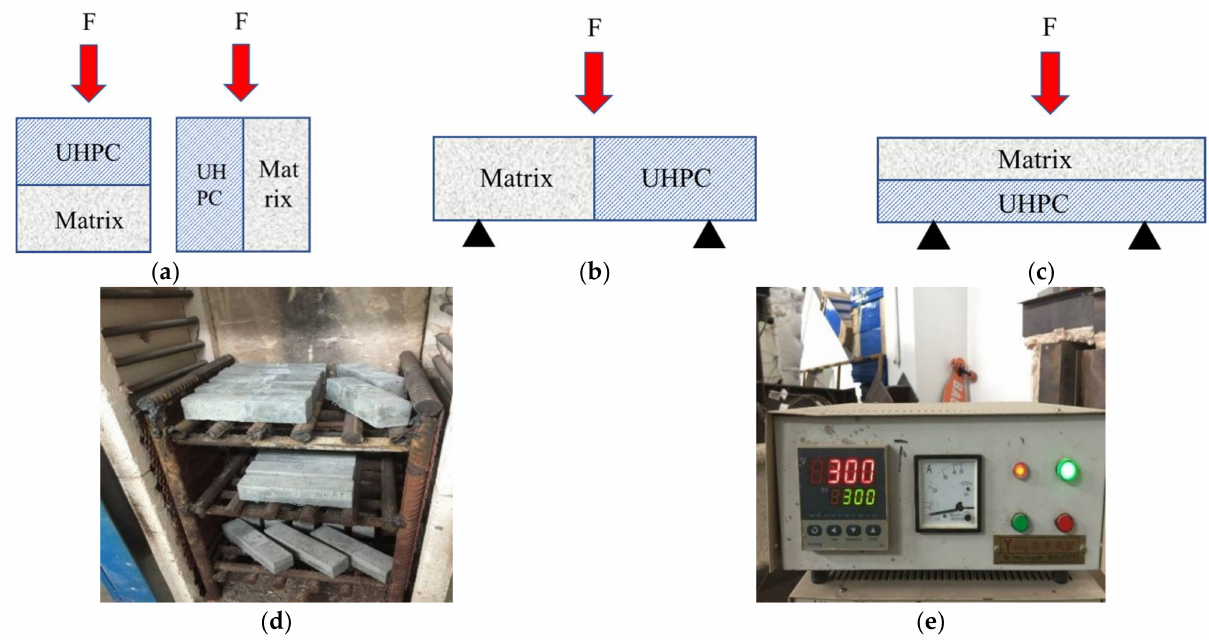
Figure 1. Sample preparation and high-temperature devices for the tests, where ( a – c ) represent the specimens utilized to assess the system’s compressive, bonding, and flexural performance, ( d , e ) represent the high temperature test furnace and its